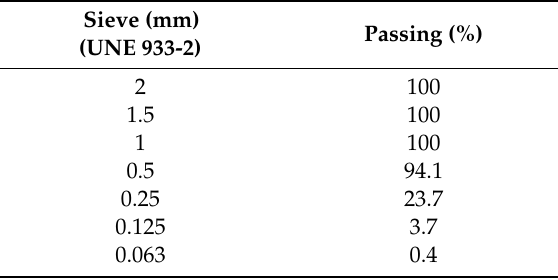
Table 1. Gradation of the crumb rubber modifier